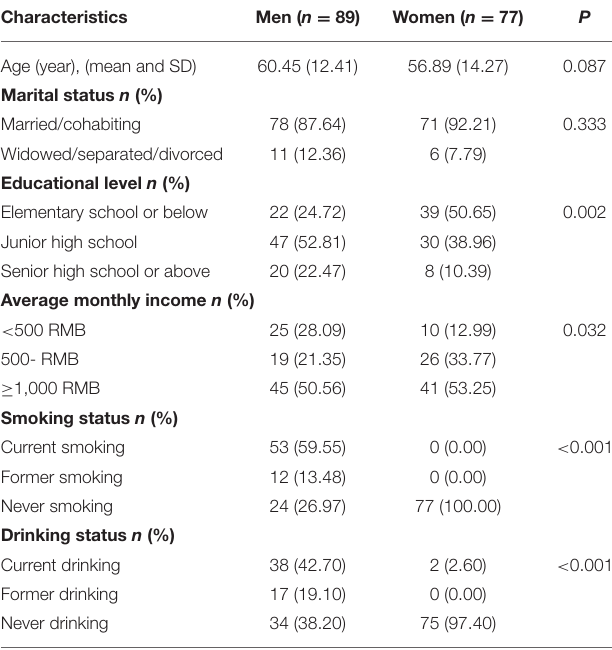
TABLE 1 | The characteristics of participants in this